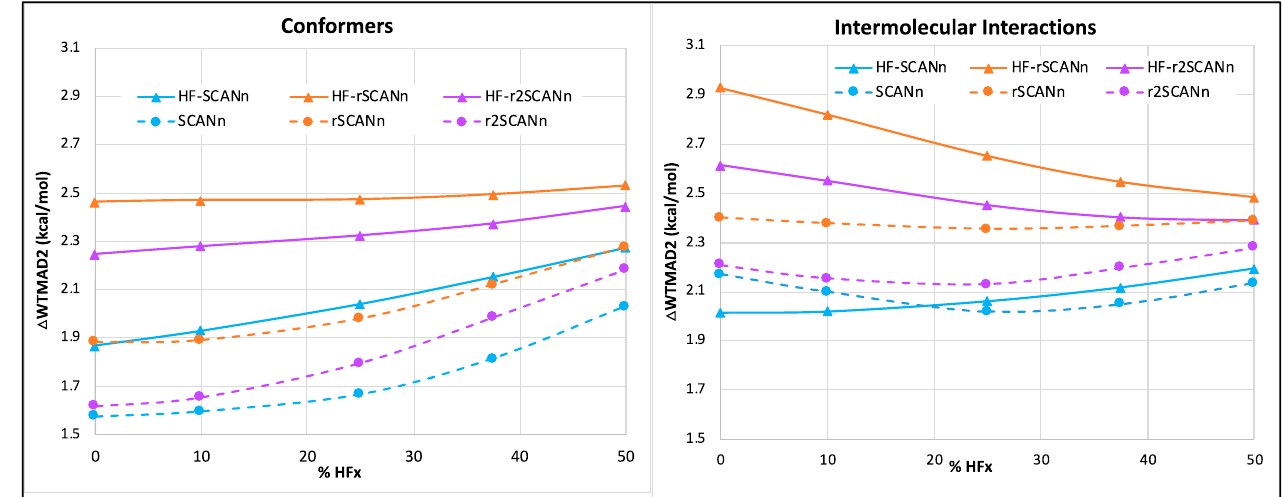
Figure 2. Trend of WTMAD2 contribution ( Δ WTMAD2 in kcal/mol) with respect to the percentage of HF-like exchange for the intermolecular interaction and conformer subsets. The solid lines represent the HF-DFTs, and the dashed lines are for the corresponding self-consistent series.